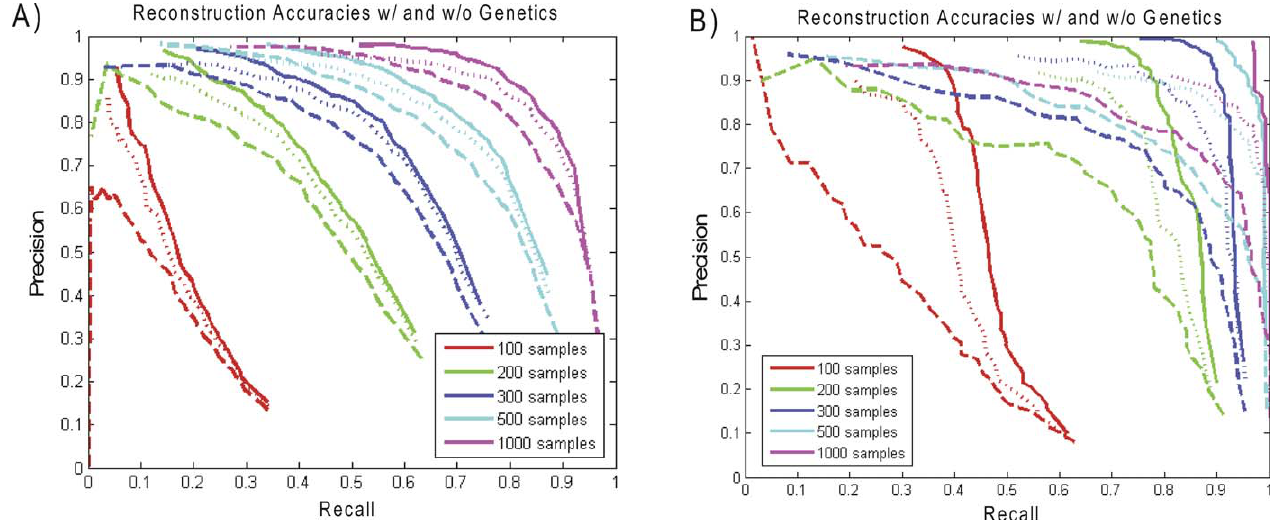
Figure 4. Reconstruction accuracy with the genetic (dotted and solid lines) and without the genetic (dashed lines) information, using varying numbers of samples, and based on an overall genetic signal similar to that found in the BXD network, but with weaker interactions (see text for details) (A) Reconstruction accuracy for the entire network. (B) Reconstruction accuracy for the subnetwork comprising only the top layer of the network. The dotted lines reflect reconstructions that utilized cis QTL information as the only source of genetic information, whereas the solid lines reflect reconstructions that utilized all available genetic information.